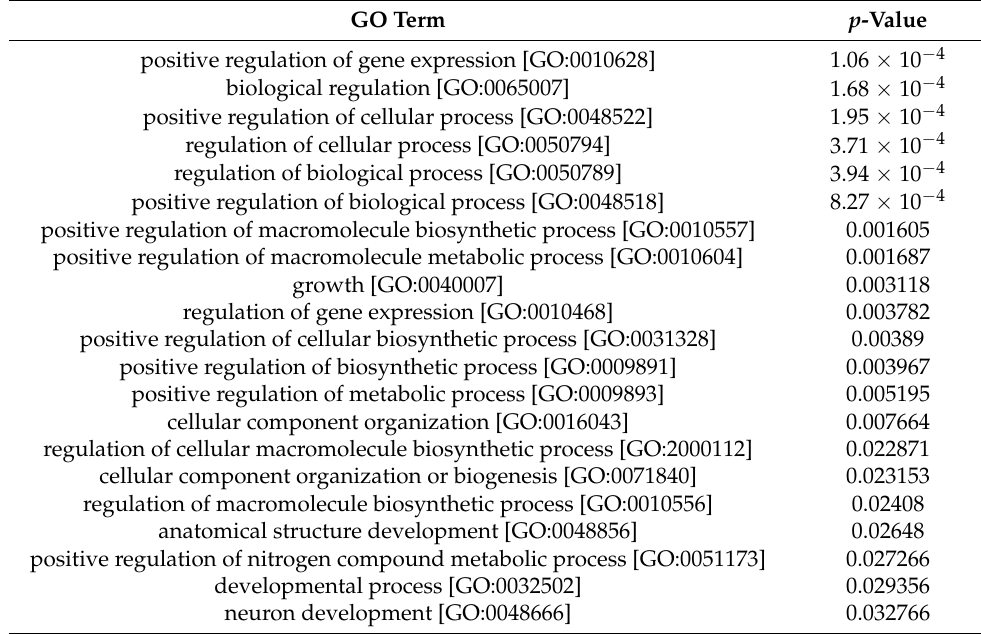
Figure 1. Differential O -GlcNAc glycoproteomics of oga del.1 male and female flies. ( A ) Venn diagrams of total glycoproteins (top) and O -HexNAc glycoproteins (bottom) identified by mass spectrometry; ( B ) stacked bar-chart showing the number of peptide spectral matches for N -linked and O -linked glycopeptides identified in both sexes; ( C ) quantification of relative abundances of O -GlcNAcylation between wild type and oga del.1 male and female flies. Frequency bars (top) show the number of PSMs plotted against log10 transformed medium-to-light ratios ( oga del.1 /WT). The distribution of medium-to-light ratio datapoints is also presented as a dot-plot (bottom). Table 1. Gene ontology analysis of O -GlcNAcylated proteins found in both males and females.